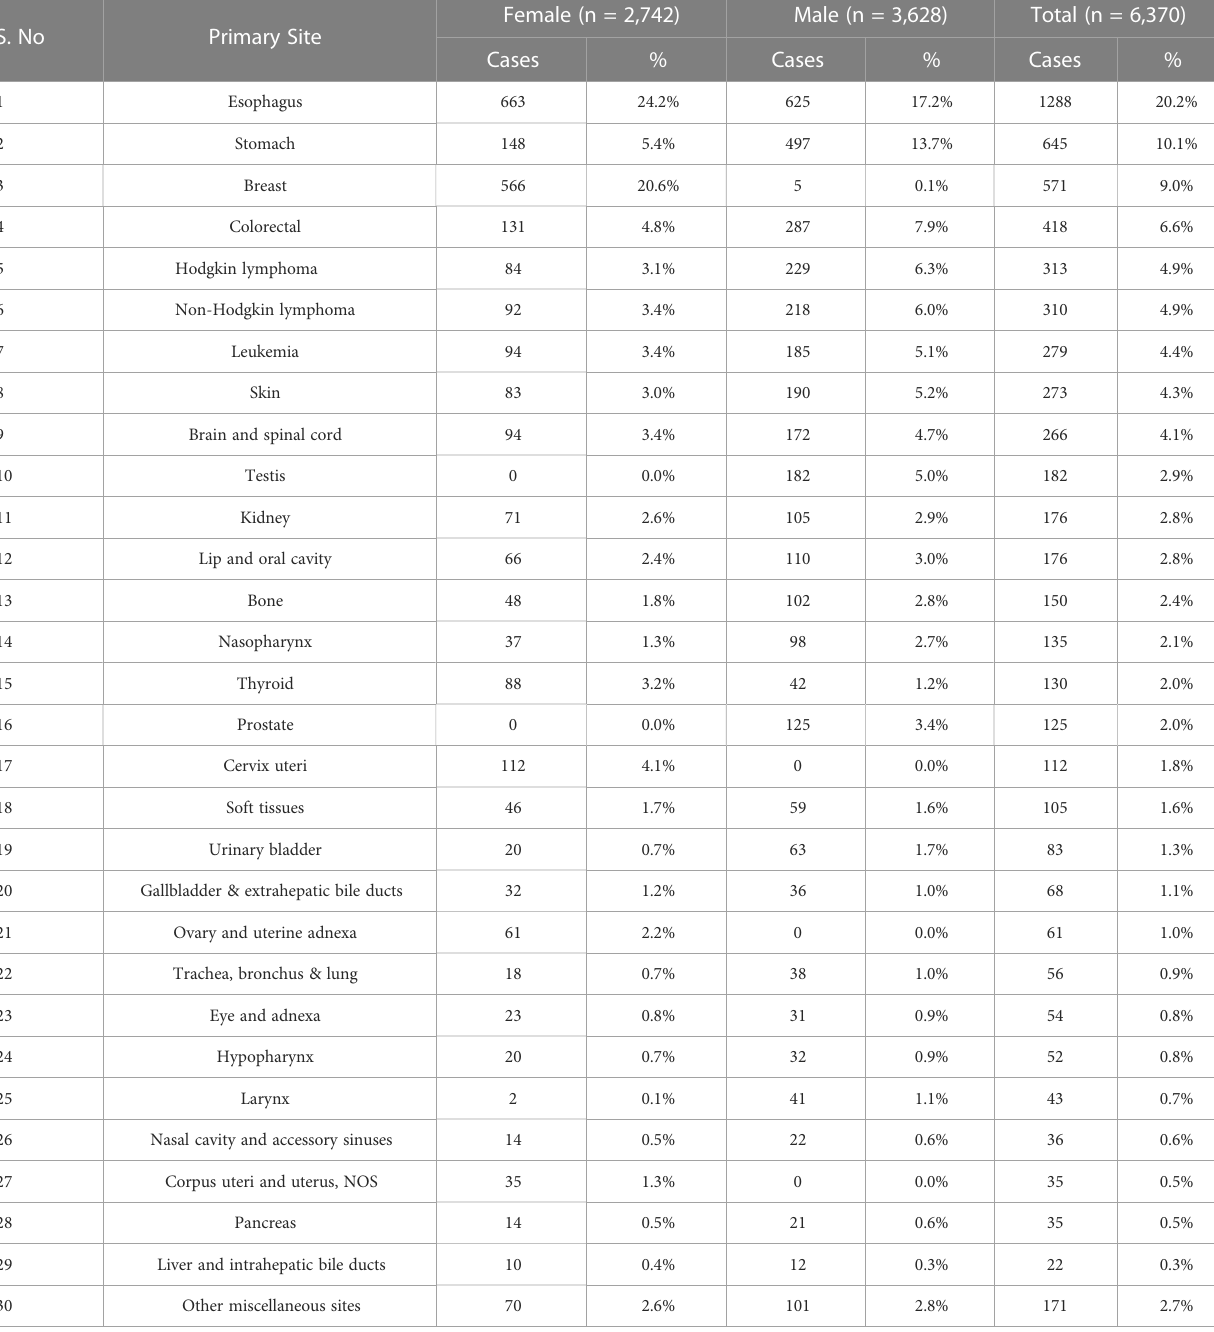
TABLE 3 Most frequent primary cancers by gender (n=